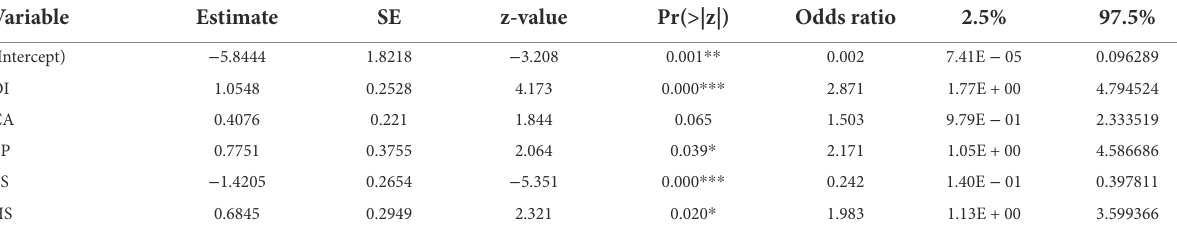
TABLE 6 Coefficients